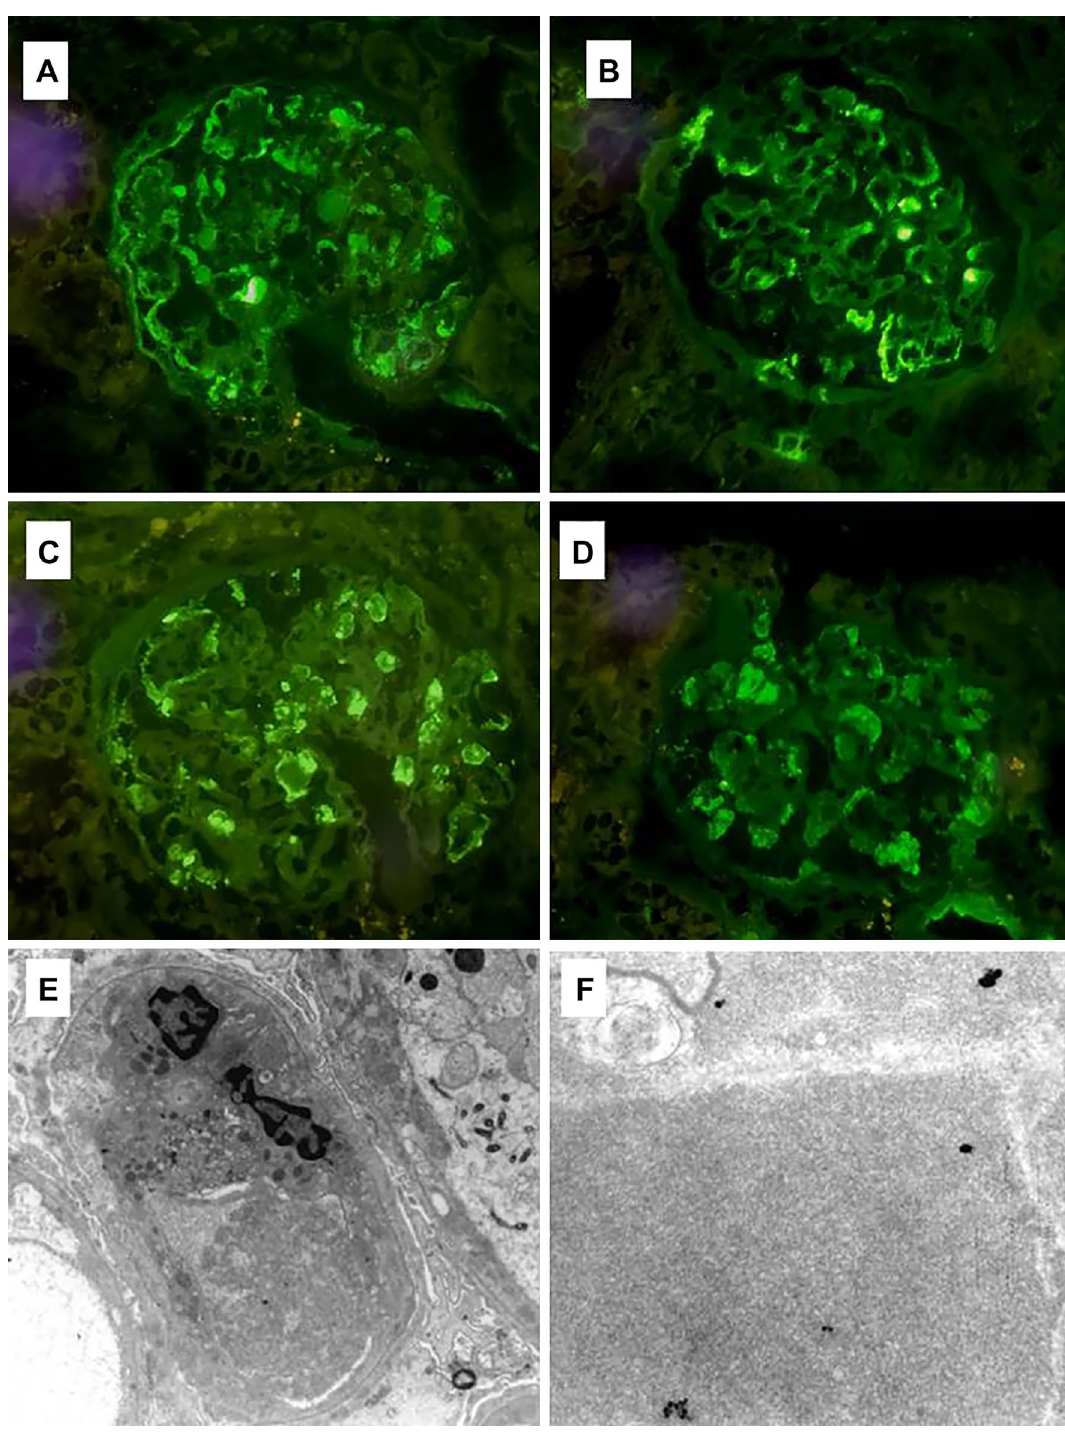
Figure 2. Immunofluorescence and electron microscopy features. Glomeruli show moderate granular positivity for IgM ( A ) and IgG ( B ) along glomerular capillary loops and within capillary lumina in intraluminal thrombi observed in light microscopy, with kappa ( C ) and lambda ( D ) deposits ( A – D , direct immunofluorescence on fresh material, original magnification × 400). ( E , F ) Transmission electron microscopy, uranyl acetate and lead citrate, ( E ) X3900 and ( F ) X21000. Capillary thrombi and subendothelial electron dense deposits with vague microtubular and annular substructure. Substructure in the electron dense deposits is more noticeable at high